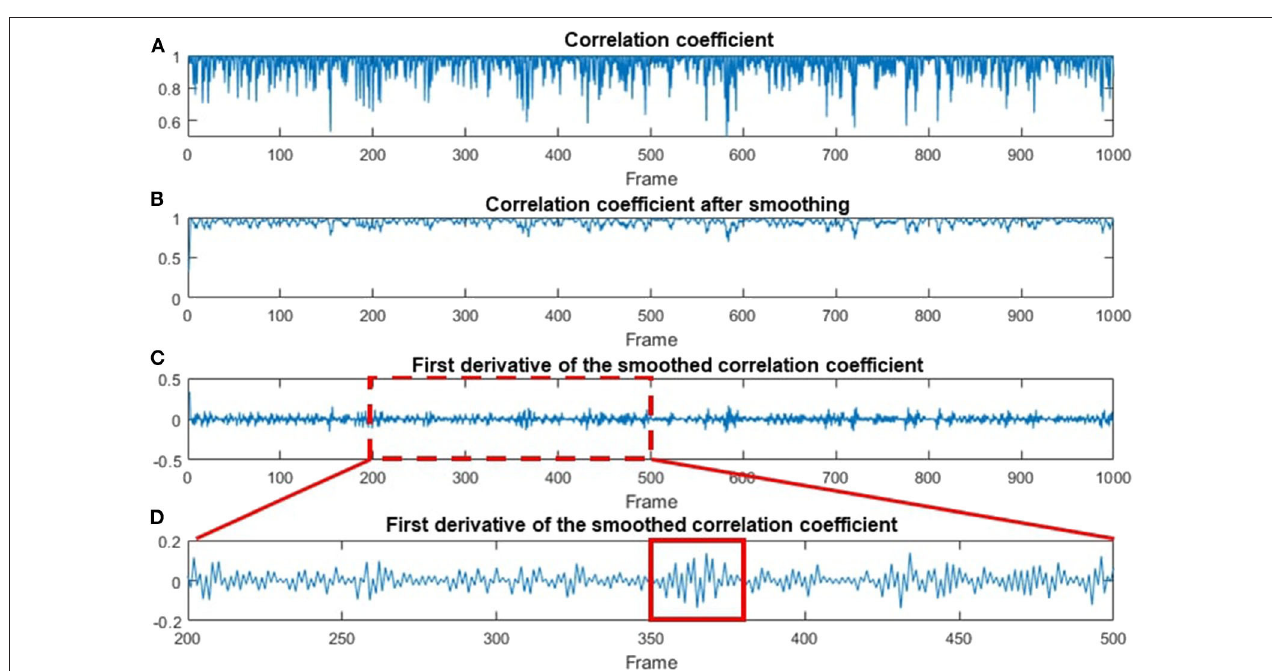
FIGURE 6 | Data processing steps based on the CC method. (A) The original CC-processed data as a function of the frame number. (B) The smoothing-processed plot of (A) . (C) The first deviation of the smoothed data in (B) . (D) A magnified plot of a section in (C) , where multiple chewing cycles can be clearly seen. A red solid line box is used to indicate one of the chewing